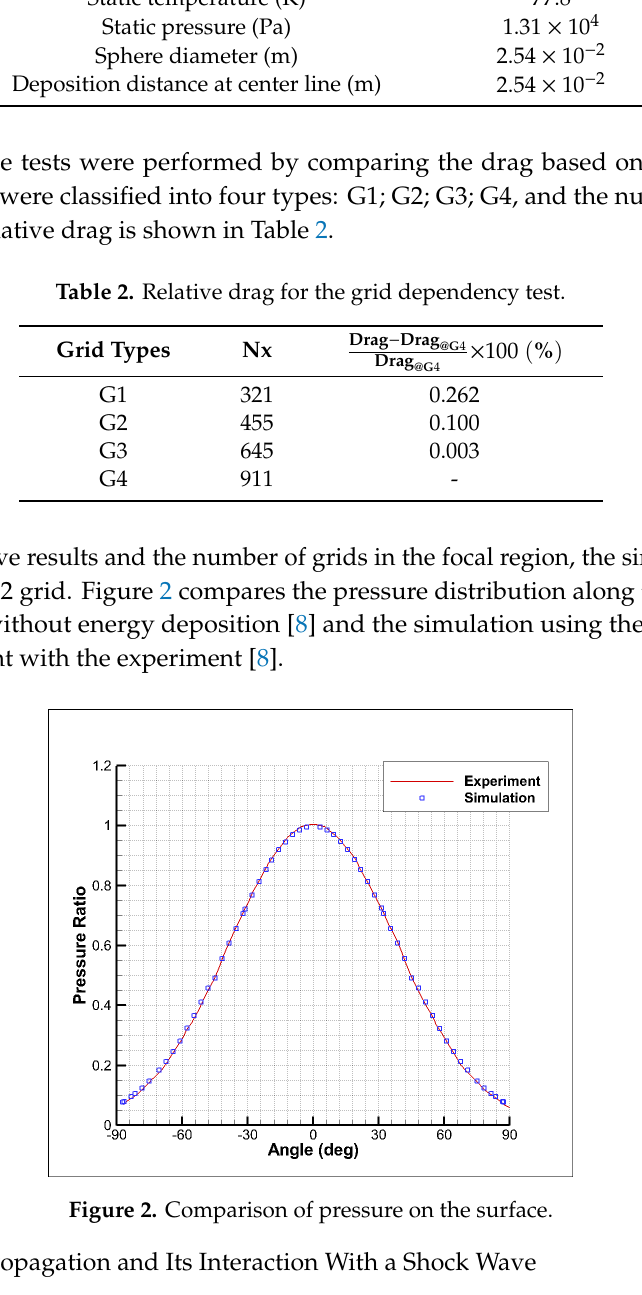
Table 1. Flow conditions in wind tunnel test (calculated).